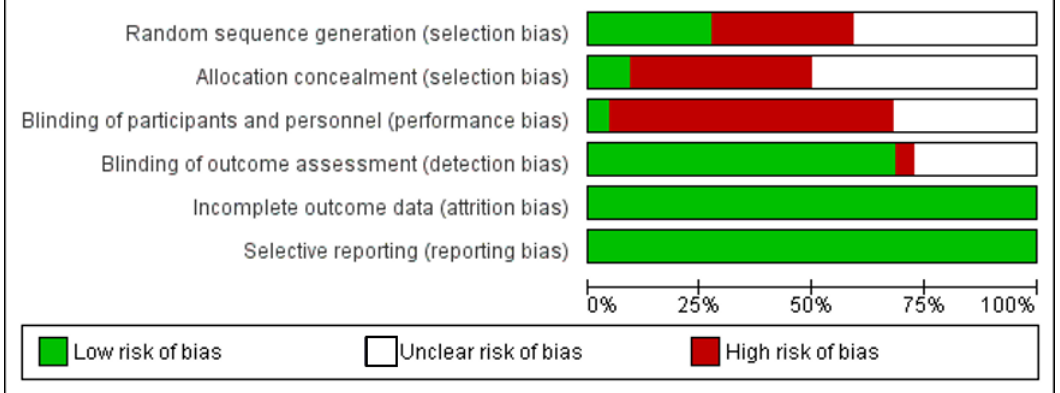
Figure 2. Risk-of-bias graph: review authors’ judgement about each risk of bias item presented as percentage across all included human studies.